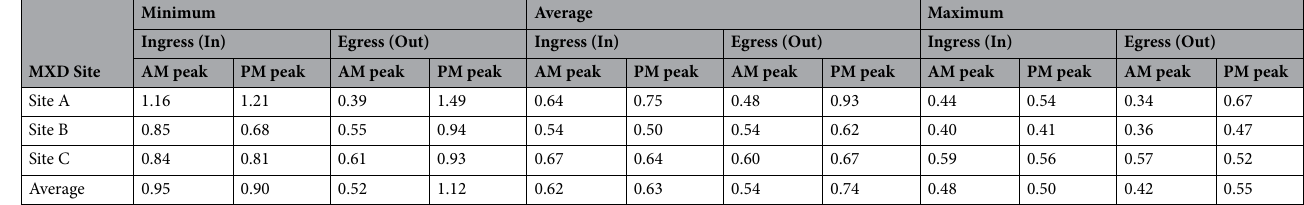
Table 7. MXDs adjustment